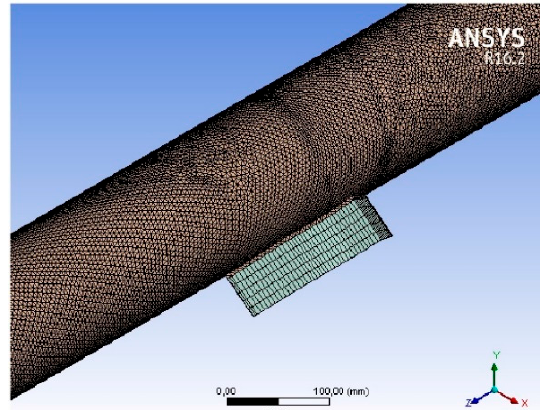
Figure 6. CFD modelling of a longitudinal crack in Ansys environment.